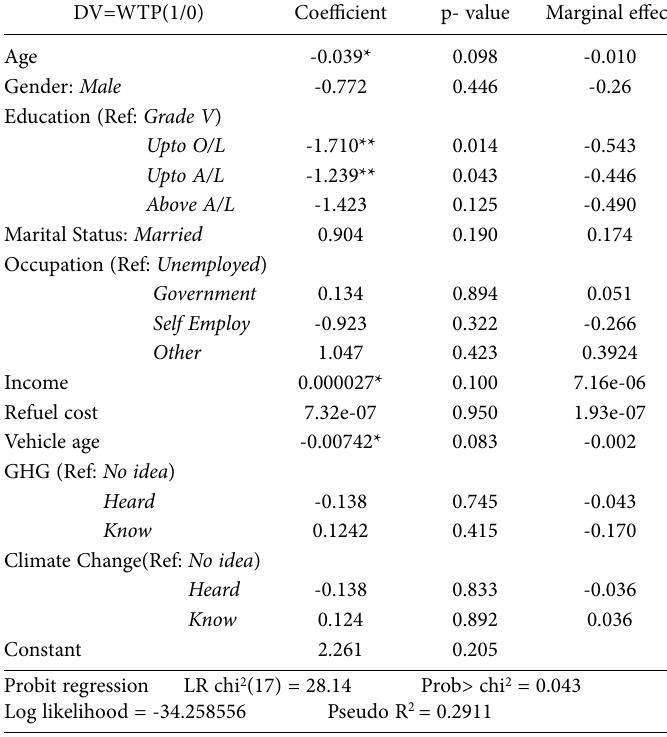
Table 4. Probit Regression results for factors affecting WTP for